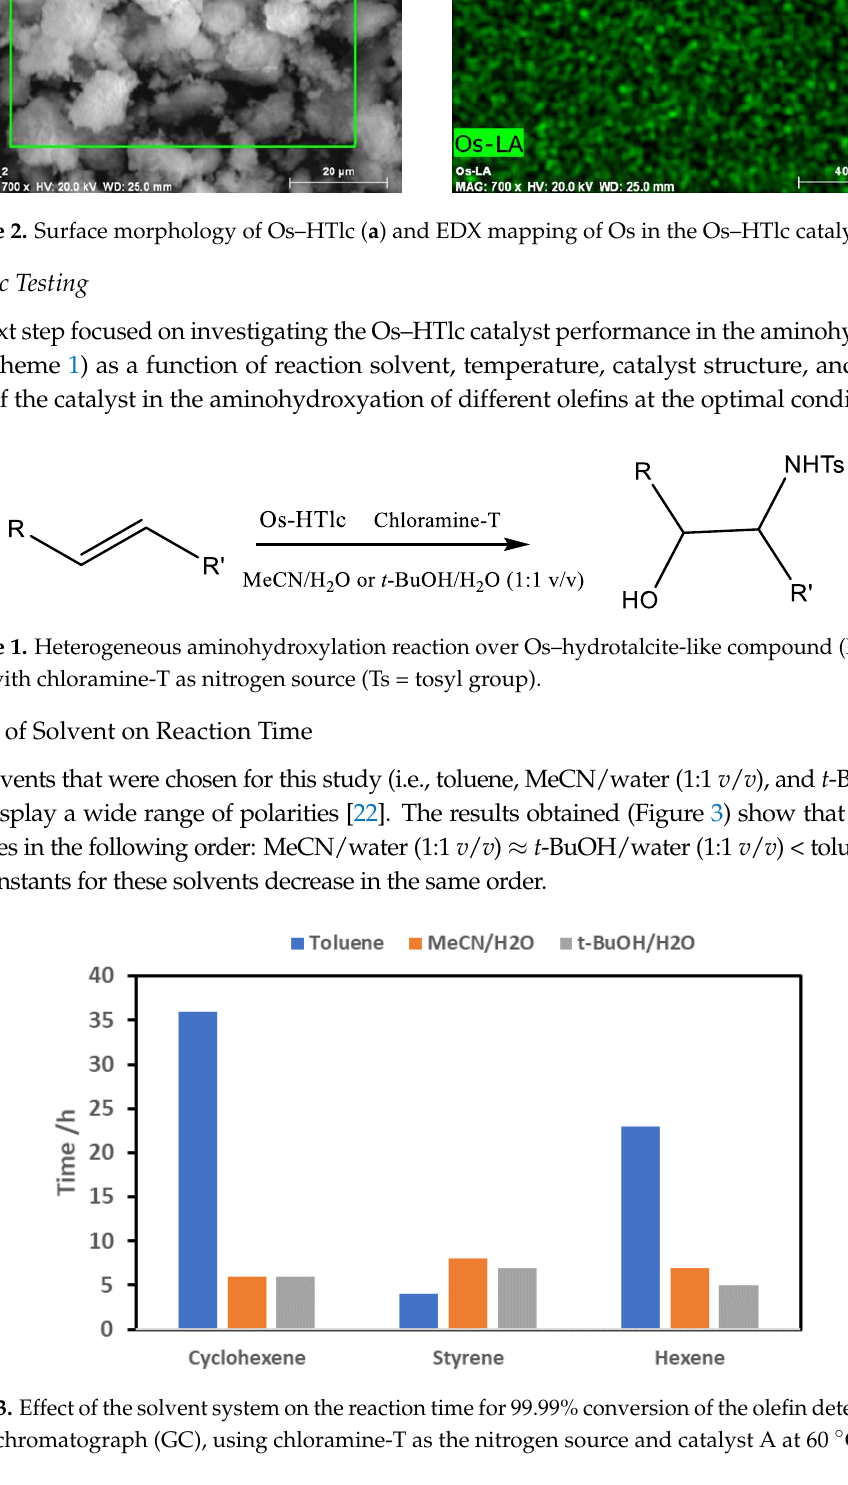
Figure 3. Effect of the solvent system on the reaction time for 99.99% conversion of the olefin determined by gas chromatograph (GC), using chloramine-T as the nitrogen source and catalyst A at 60 °C.